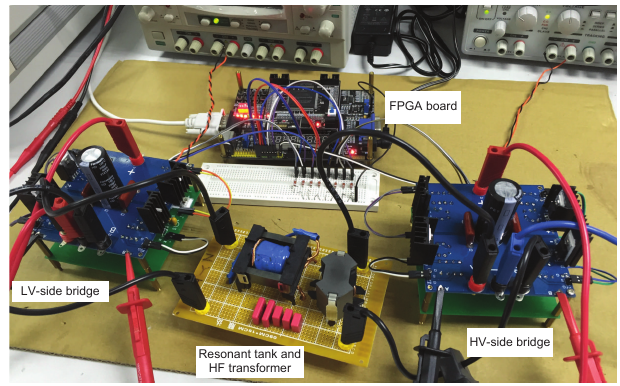
Figure 10. Experimental setup of the DBSRC. HV, high voltage; LV, low voltage.